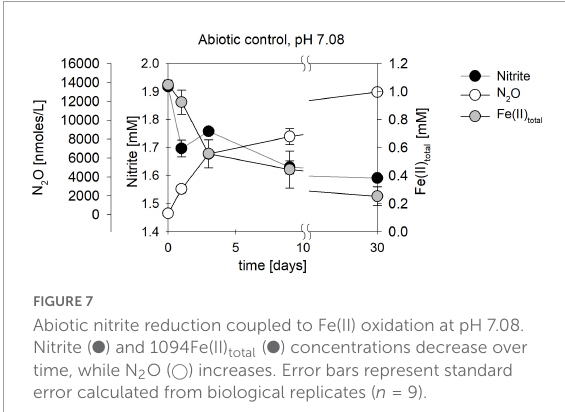
FIGURE7 Abiotic nitrite reduction coupled to Fe(II) oxidation at pH 7.08. Nitrite ( (cid:108) ) and 1094Fe(II) total ( (cid:108) ) concentrations decrease over time, while N 2 O ( (cid:13) ) increases. Error bars represent standard error calculated from biological replicates ( n =